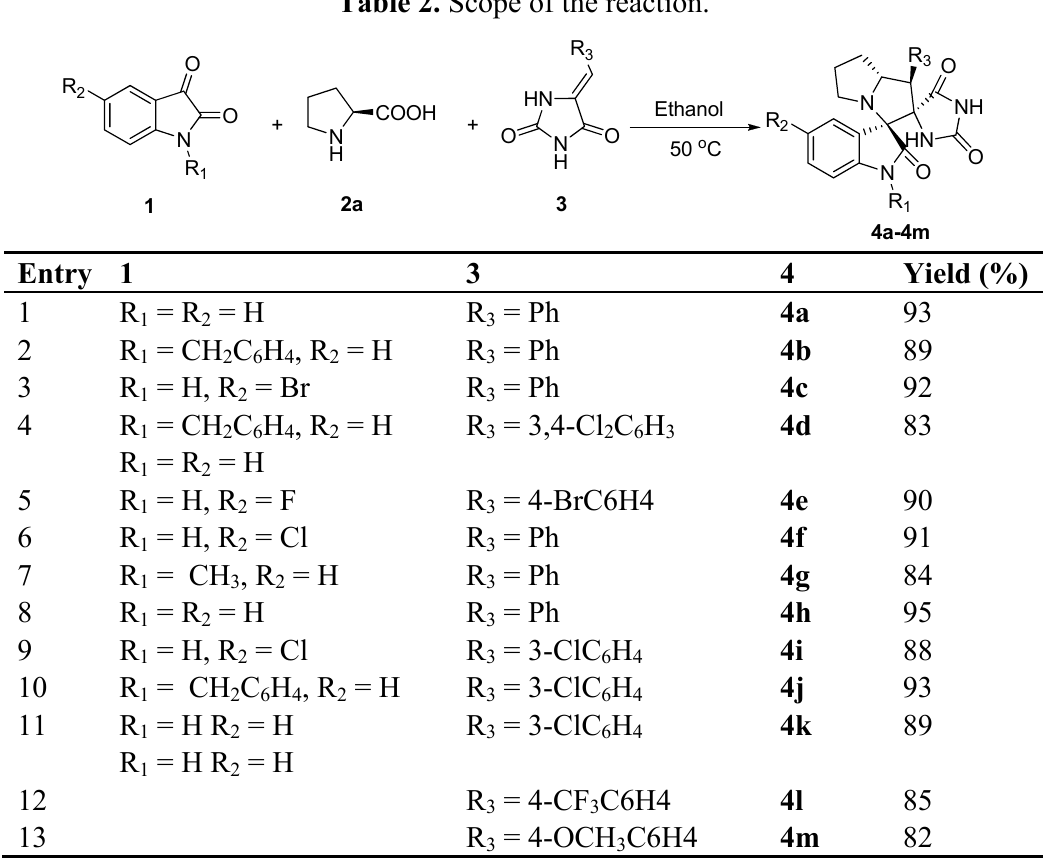
Table 2. Scope of the